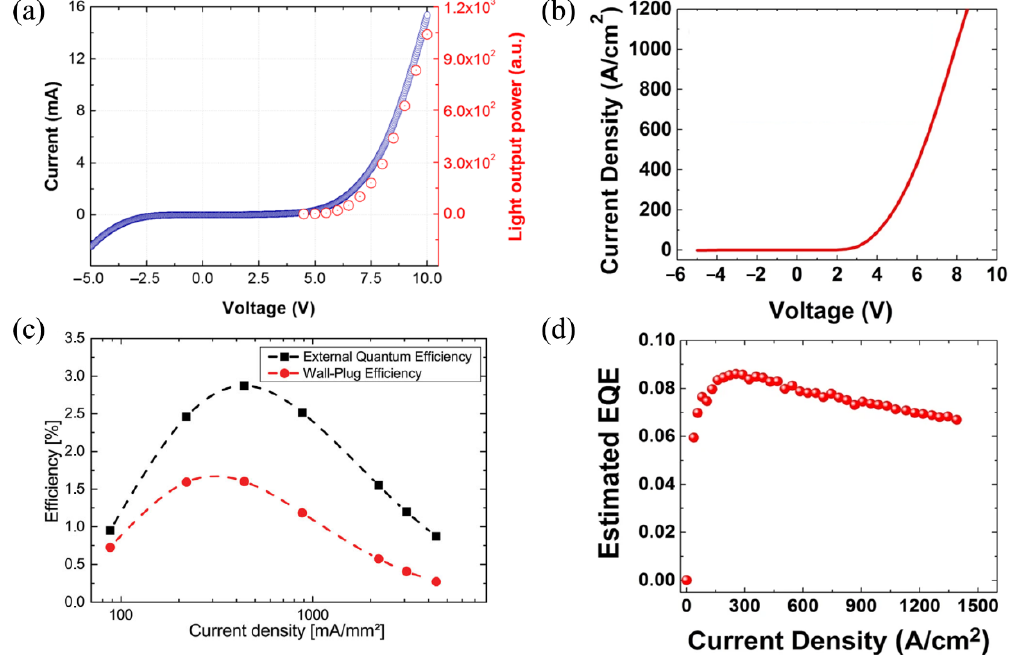
Figure 3. ( a ) I–V characteristic (blue) and light output power (red) of a microrod LED with